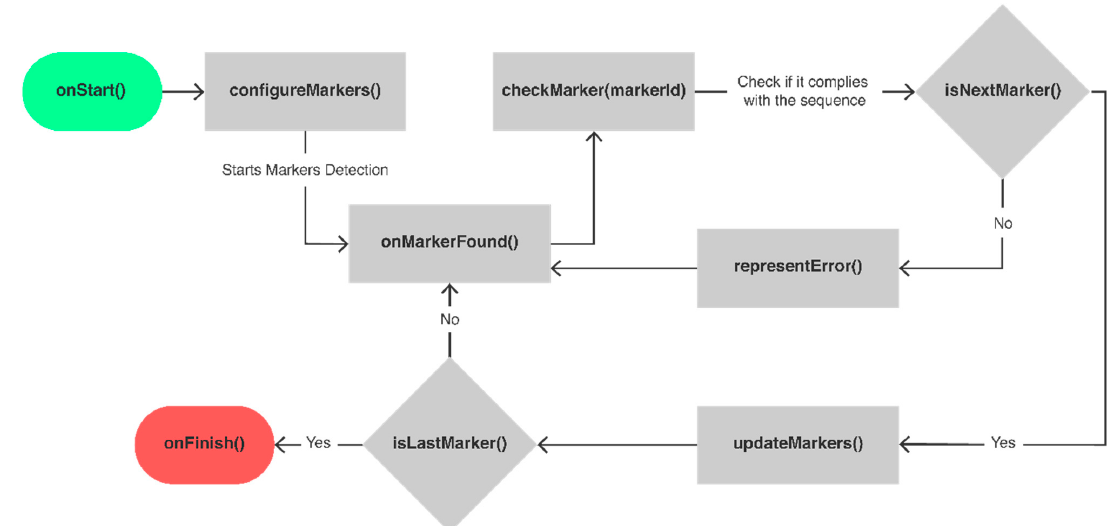
Figure 8. Simplified logic cycle of the implementation, which describes how the experience works from start to finish. The round shapes represent lifecycle events, the rectangles the methods and functionalities, and the diamonds a Boolean conditional statement check. Table 3. Meanings of the four statuses that define the markers during the AR experience. States of the Meaning Markers